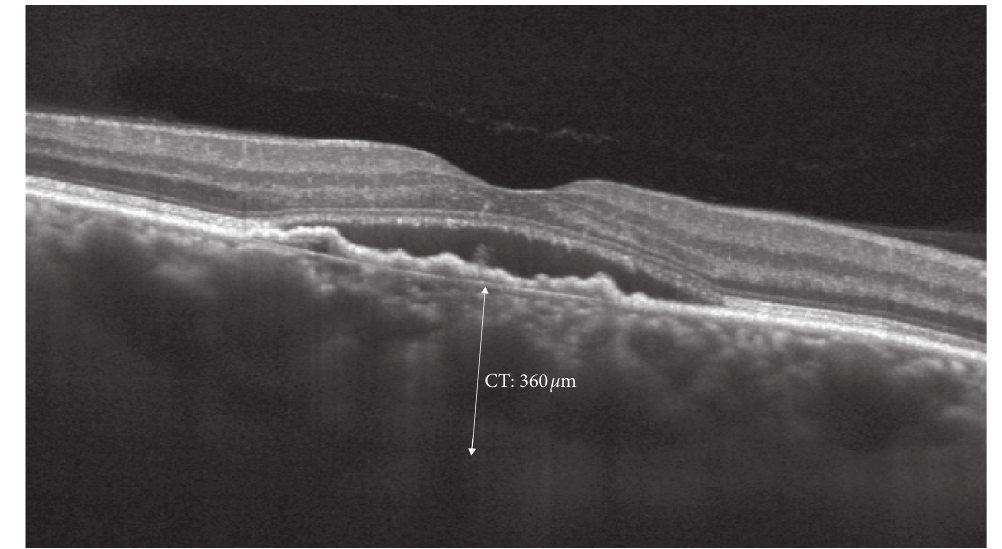
Figure 10: Structural biomarker: manual caliper to measure choroidal thickness (CT). Table 1: Summary of OCT biomarkers and prognostic